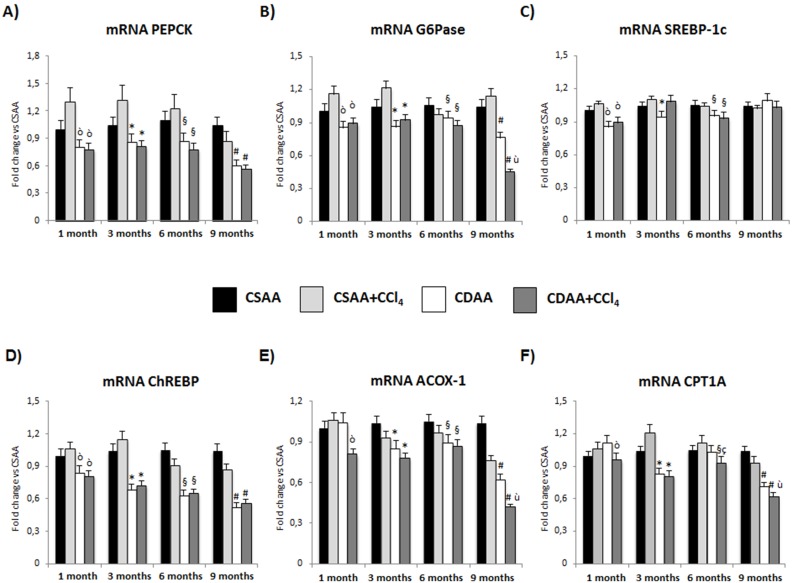
Gene expression of elements involved in carbohydrate and lipid metabolism.qRT-PCR expression shows a progressive decrease of the amount of PEPCK (A), G6Pase (B), ChREBP (D), ACOX-1 (E) and CPT1A (F) mRNA expression in the groups of CDAA or CDAA+ CCl4, while only a slight decrease is observed for mRNA expression of SREBP-1c (C). Data represent mean ± SD; ò p<0.05 vs CSAA 1 month; *p<0.05 vs CSAA 3 months; §p<0.05 vs CSAA 6 months; #p<0.05 vs CSAA 9 months; ç p<0.05 vs CDAA 6 months; ù p<0.05 vs CDAA 9 months.